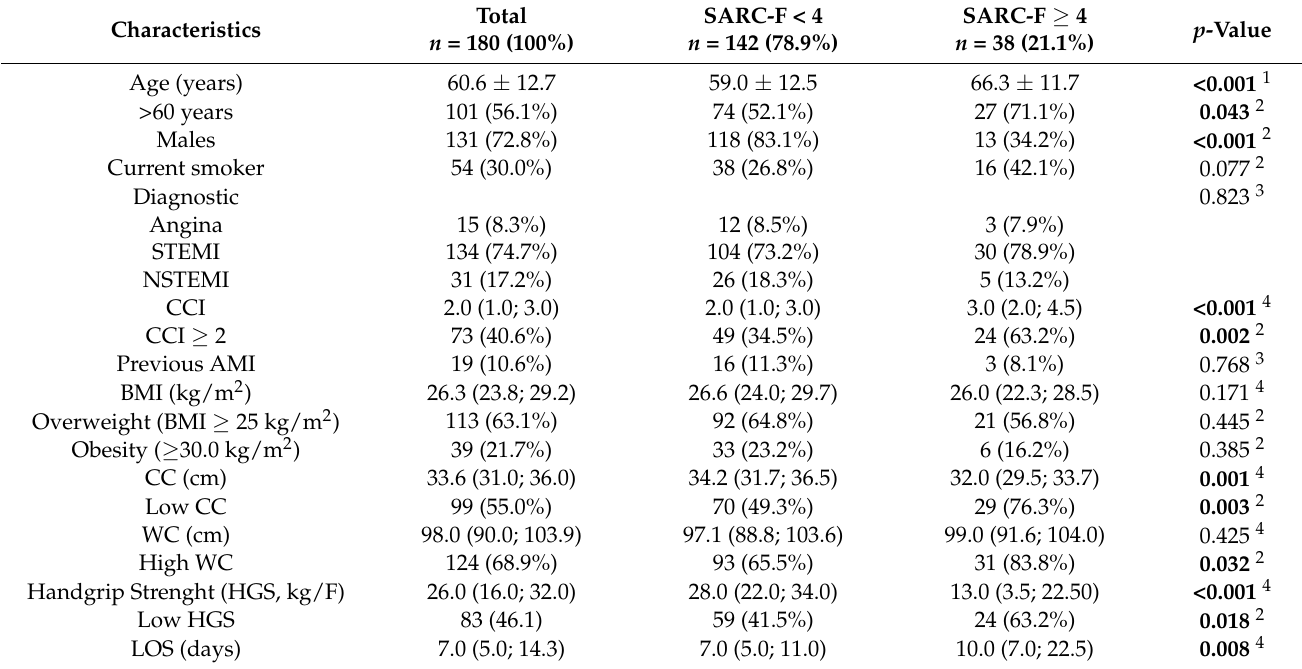
Table 1. Sociodemographic, clinical and nutritional characteristics of patients after acute cardiovascu- lar event at baseline ( n = 180).